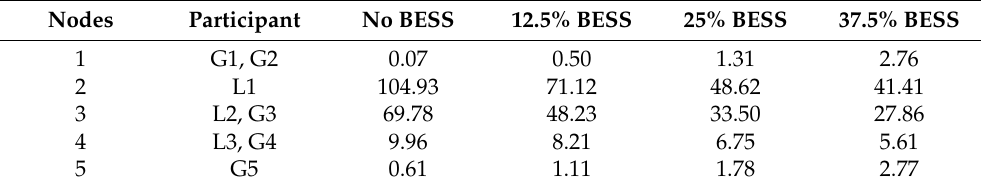
Table 7. Variance of LMPs at all